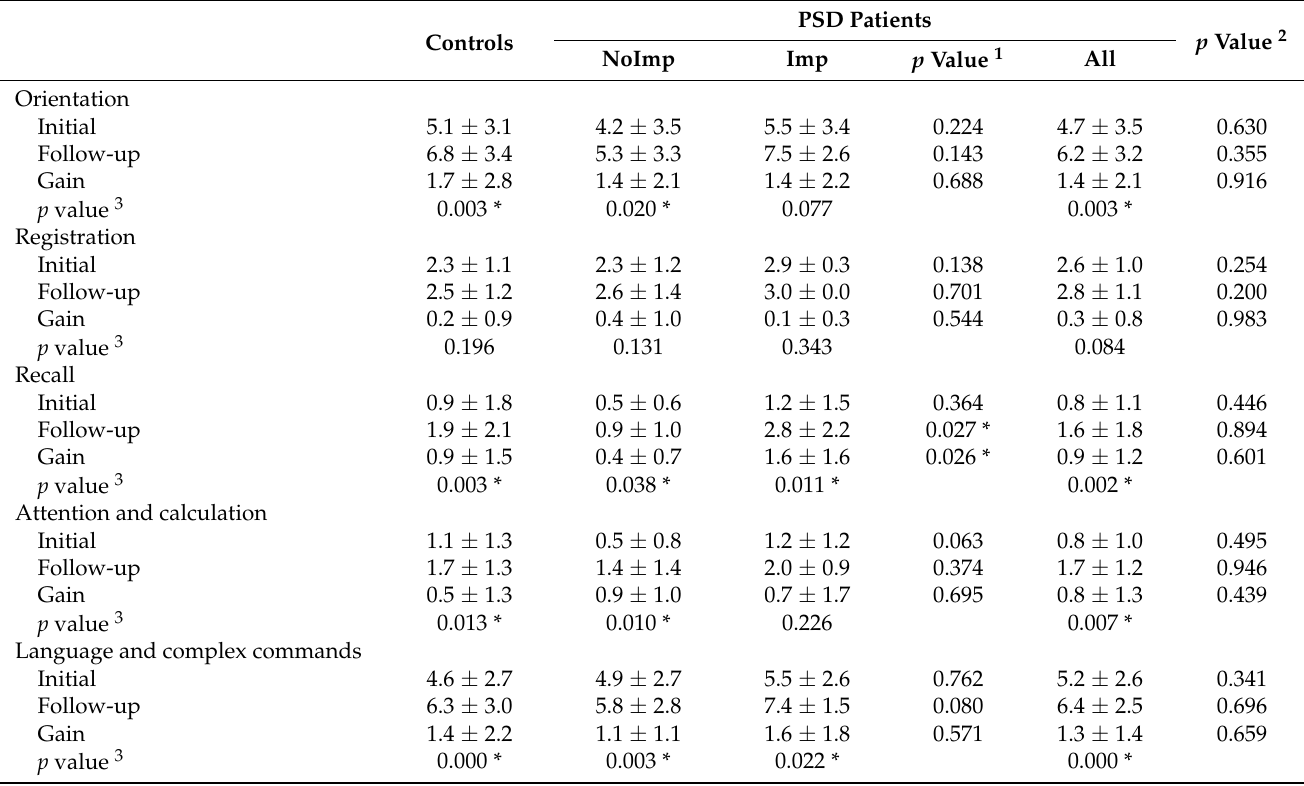
Table 3. Initial and follow-up results of K-MMSE categories for controls and PSD patients.